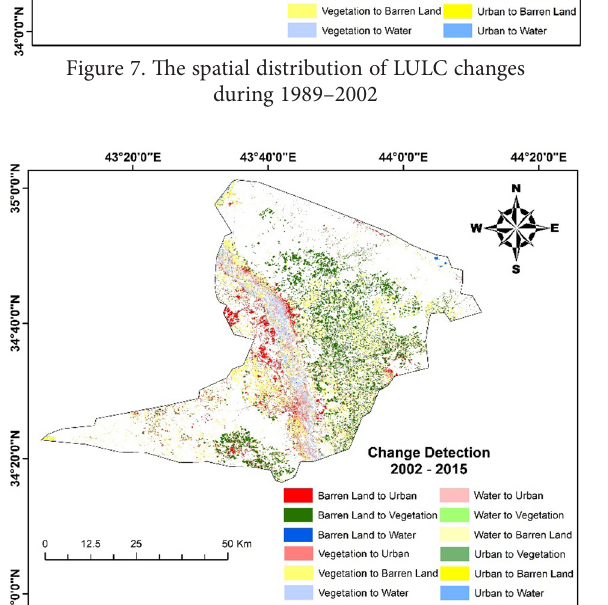
Figure 9. The spatial pattern of LULC